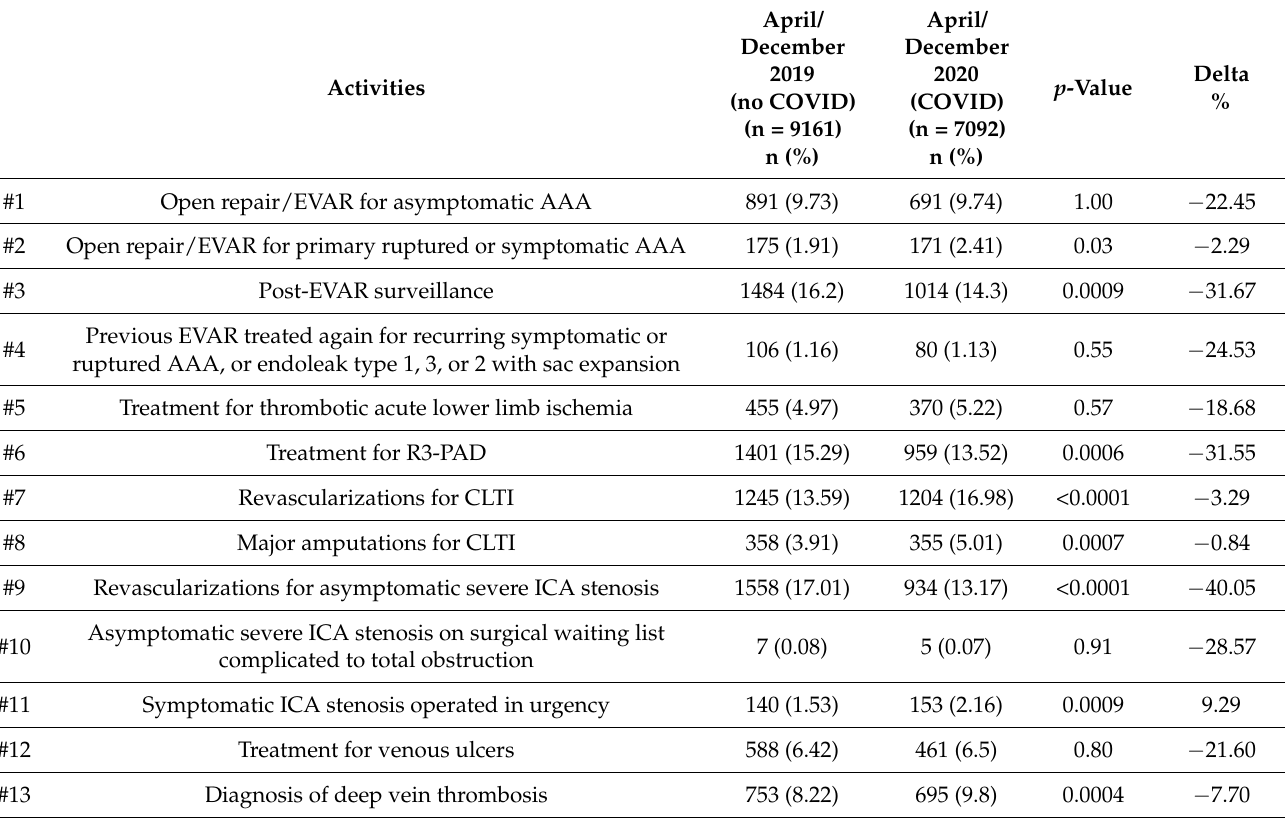
Table 2. Summary of the responses to the questionnaire for the COVID-19 period from April